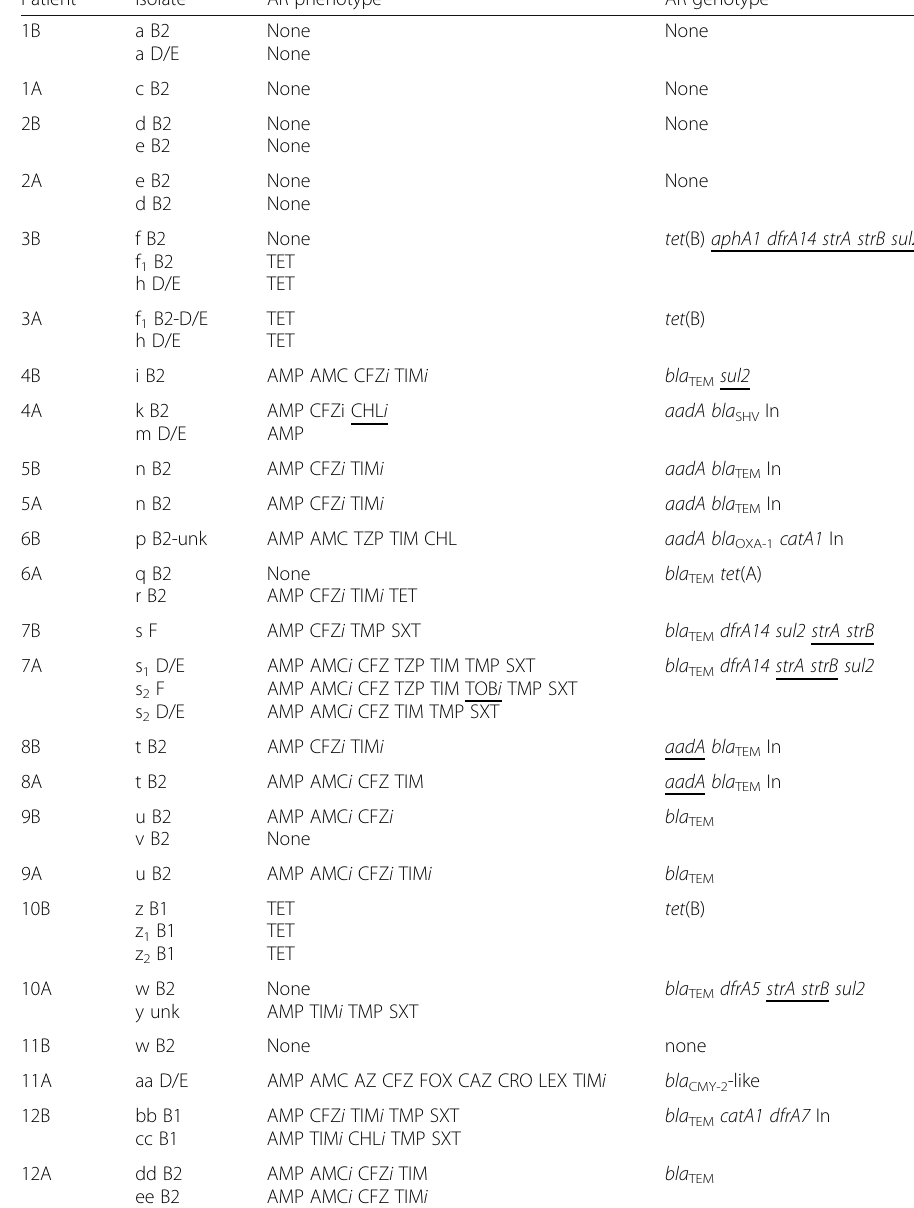
Table 2 Antimicrobial resistance (AR) profiles of isolated E . coli representatives Patient Isolate † AR phenotype